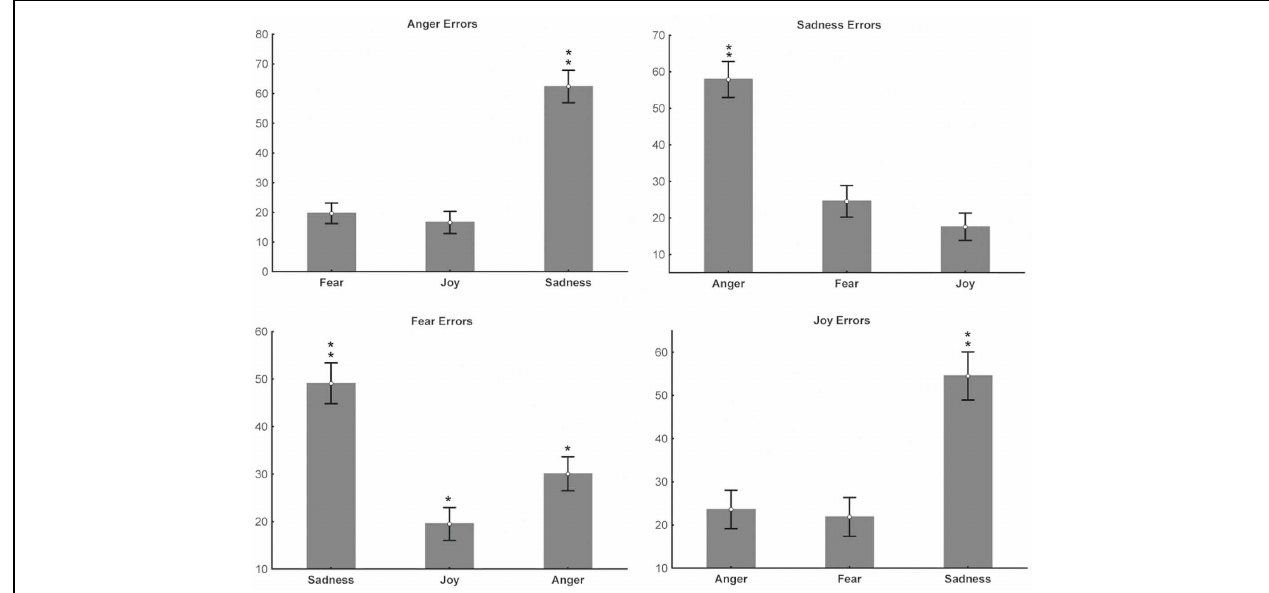
emotion labels is expressed as percentage (indicated in Y axis). Anger : ∗∗ ps < 0 . 005; Sadness : ∗∗ ps < 0 . 005; Fear : ∗ p < 0 . 001, ∗∗ ps < 0 . 005; Joy : ∗∗ ps < 0 . 001.